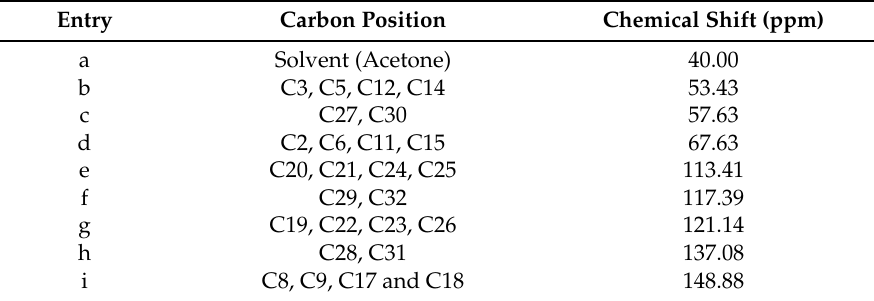
Table 3. 13 C-NMR signal assignments for the azacrown polyether.